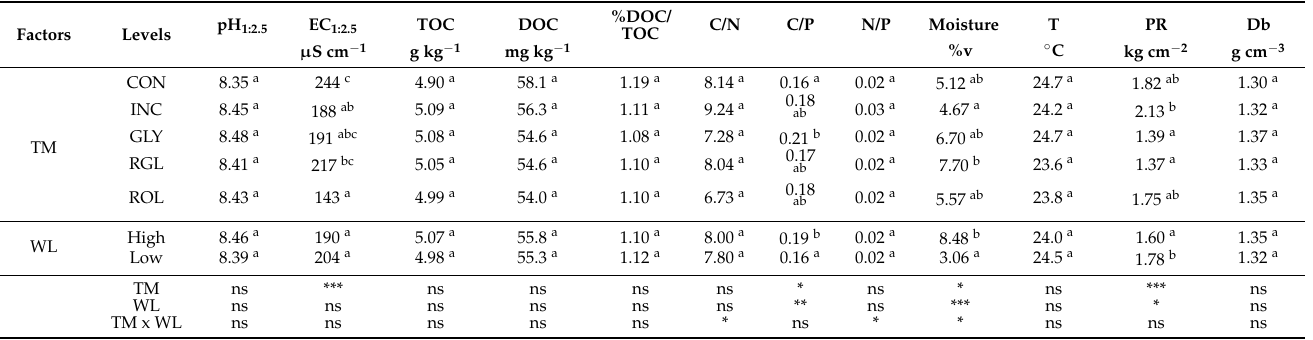
Table 3. Soil physicochemical variables as affected by termination method (TM) and water level (WL) at 57 DAS maize.